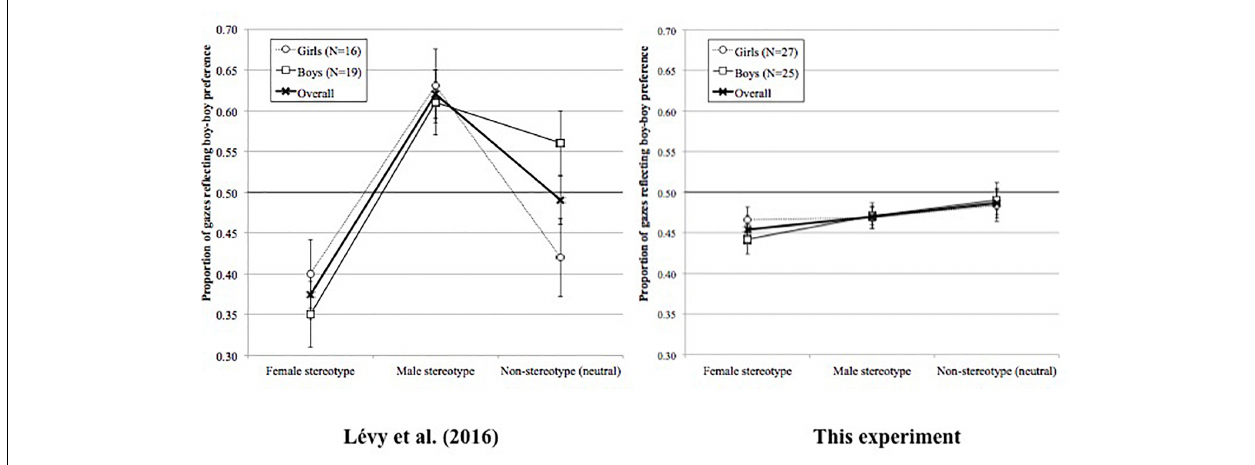
FIGURE 4 | Proportions of gazes in Lévy et al. (2016); © Reprinted with permission of Cambridge University Press) and in the present experiment reflecting a boy-boy preference in all three stereotypical conditions overall and split by sex of